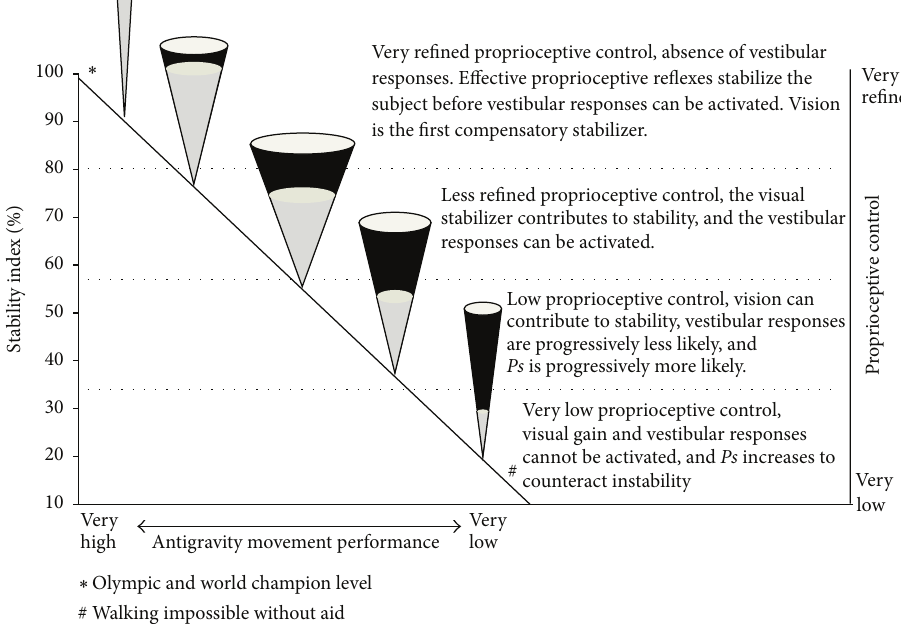
Figure 6: Single stance test (ST): model of interpretation. The impairment of stability is faced first by widening the postural cone ( PIxy ) and then by activating the precautionary strategy ( Ps , black area of the cone in %). Then, if necessary, Ps increases further while PIxy tends progressively to become smaller. This behavior is observed both in eyes open and eyes closed (EC) conditions, even if in the latter condition it is more evident. The stability index of EC trials is an indicator of the effectiveness of proprioceptive control, even if the vestibular component is not excluded. From top to bottom higher values of stability index indicate more refined proprioceptive control. Didactically four functional zones can be identified (their dimensions are approximate). At the lower level of stability, the subject is unable to maintain the single stance without continuous hand support and cannot walk without aid. ST levels correspond to different antigravity movement performances.